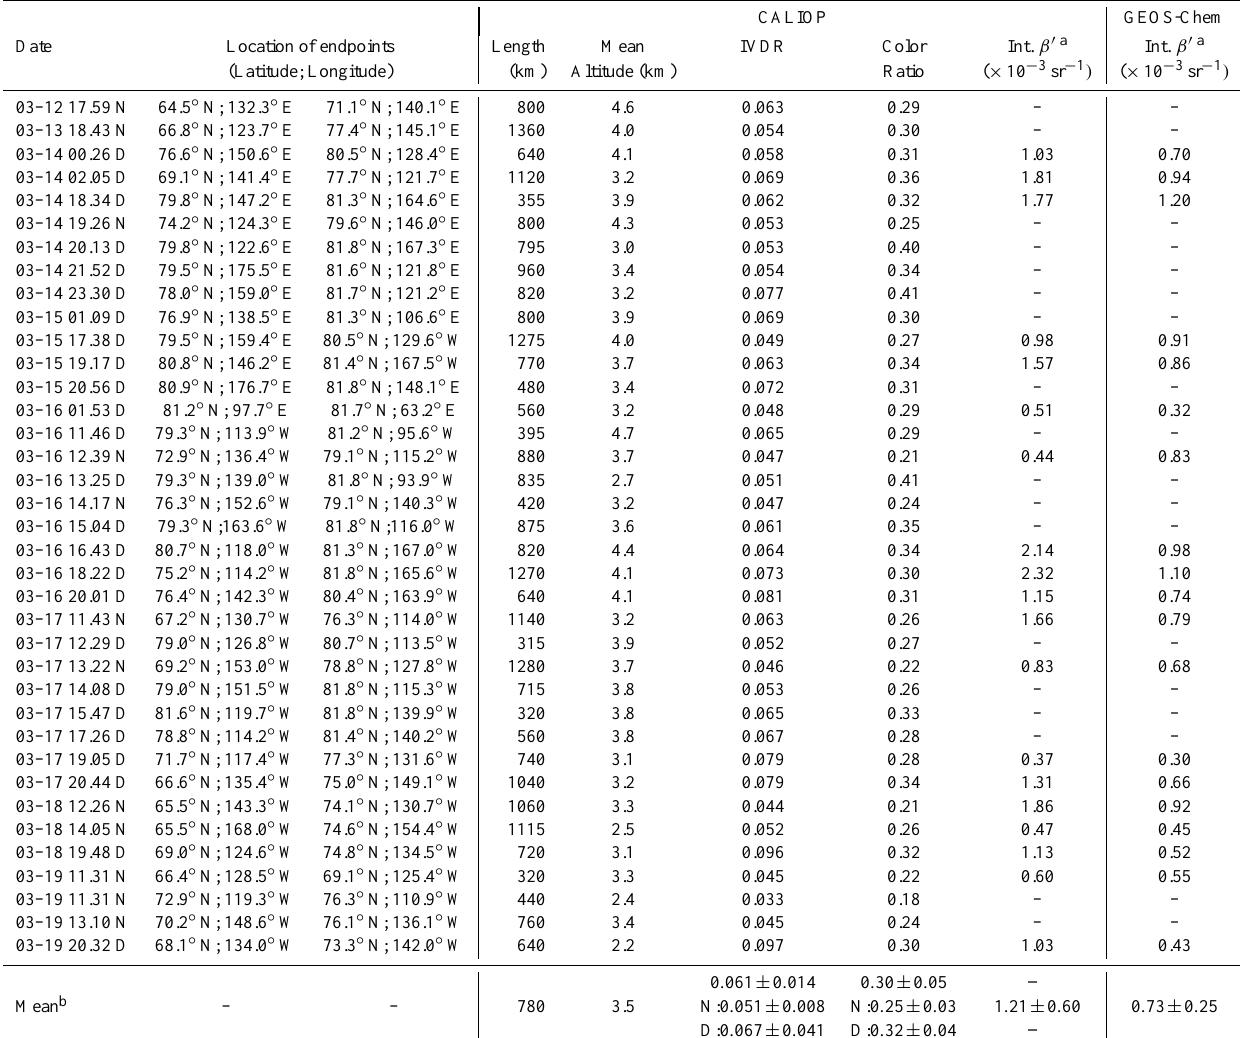
Table 2. Summary of the 37 Arctic aerosol layers observed by CALIOP during the 12–19 March export event. Refer to Table 1 for the legend.